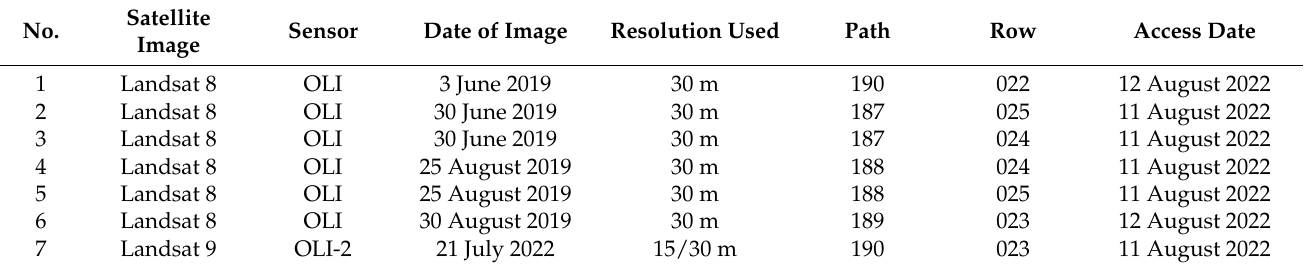
Table 1. The data sources used for Figures 2 and 4 (United States Geological Survey data basis